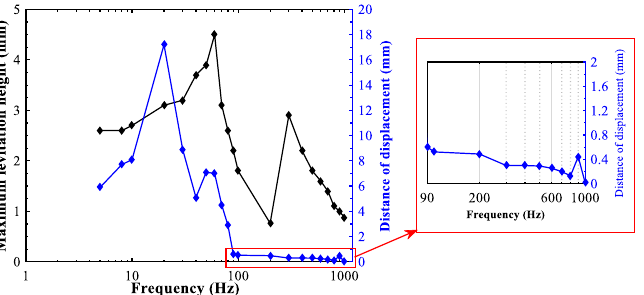
Figure 6. Evolution of the particle’s levitation height and its displacement distance as a function of the frequency. Conditions: V = 1000 V, d p = 60 µ m, q p = 10% q ps , x 0 = 4.3 mm, t = 1 s.